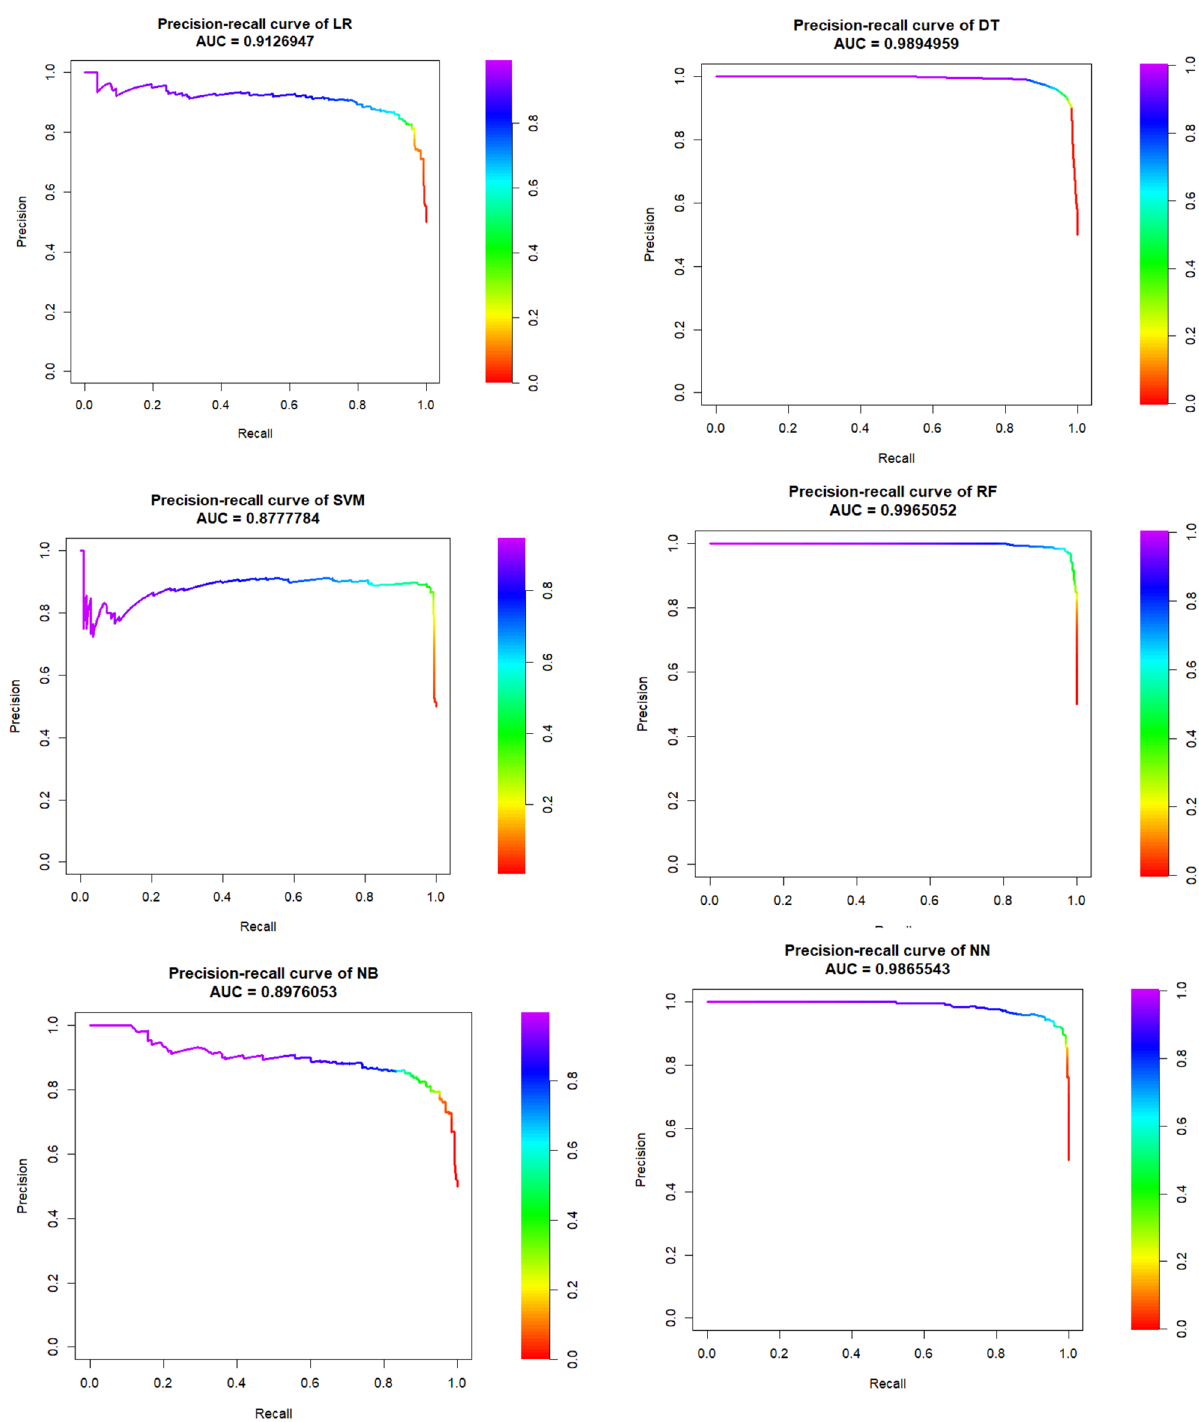
Figure 3. Precision-recall curve and its AUC in six ML algorithms of balanced train dataset of gastric cancer